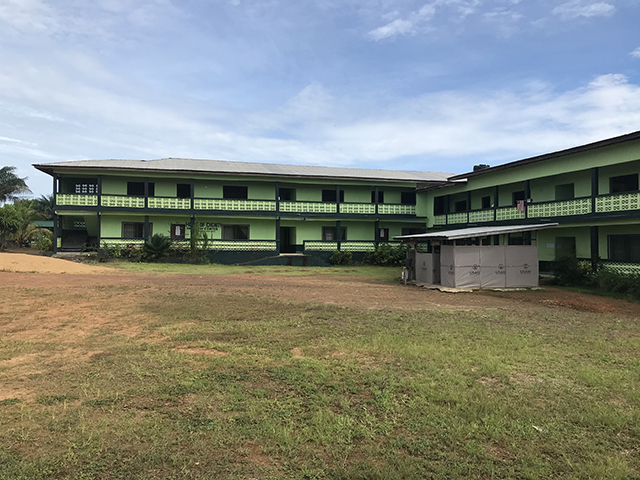
Patient ward at Home of Dignity Health Center.